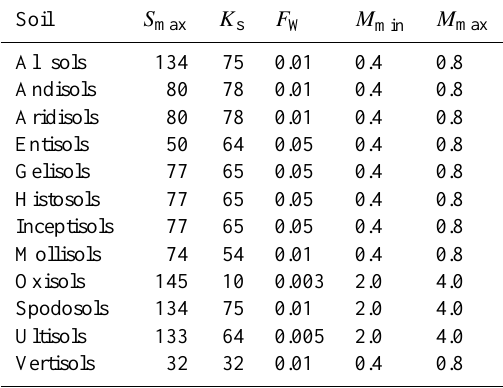
Table E2. Soil order specific values of model